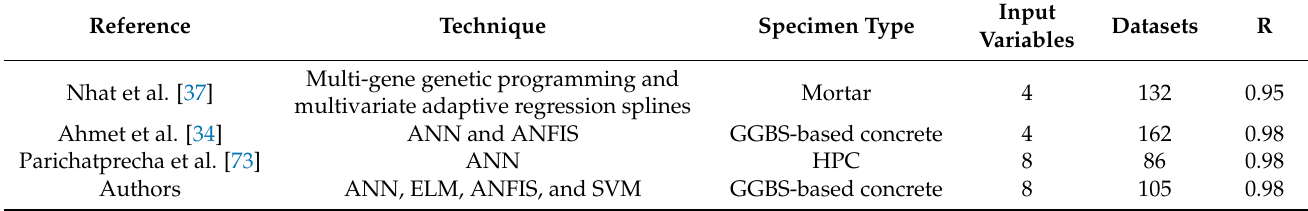
Table 5. Comparison of the results with the existing AI models.